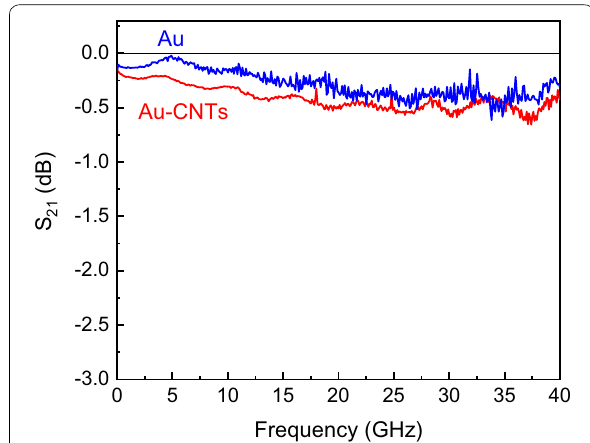
Fig. 8 Isolation characteristics of Au–Au/CNT‑composite contact RF‑MEMS switch in the OFF state